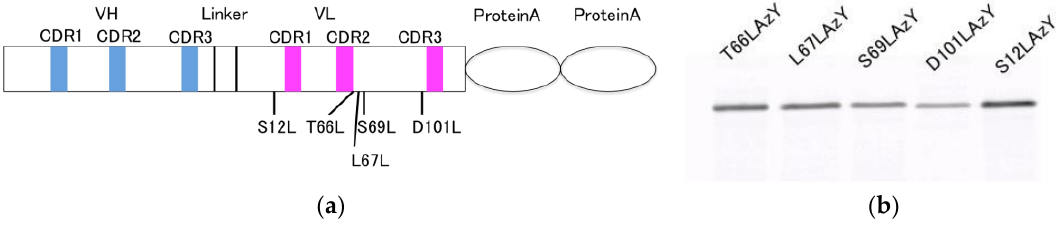
Figure 2. Expression of Cy3-labeled anti-Nef antibody constructed using the in vivo UAA incorporation system. ( a ) Scheme of the anti-Nef antibody gene. ( b ) Fluorescence image of SDS-PAGE of the expressed and modified Nef Q-bodies.